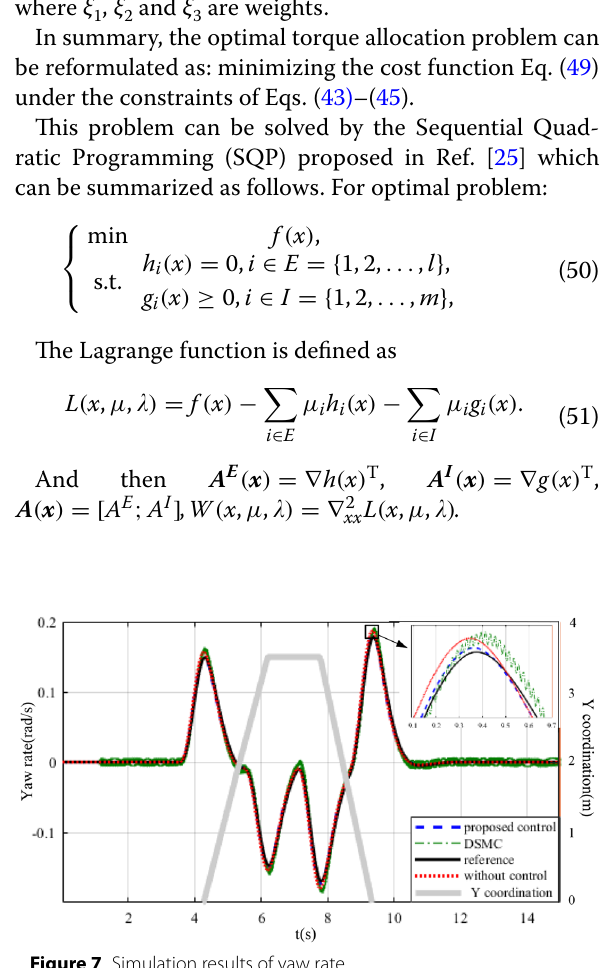
Figure 7 Simulation results of yaw